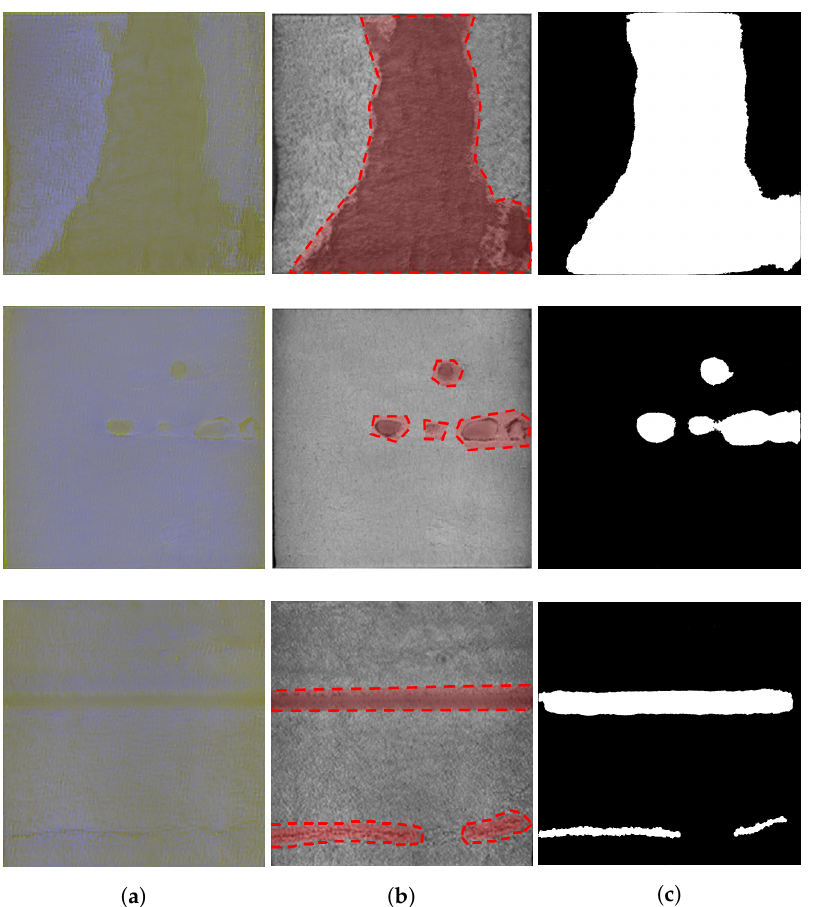
Figure 7. ( a ) Synthetic RGB images; ( b ) texture channel of Synthetic images with the defects in red ( c ) ground truth